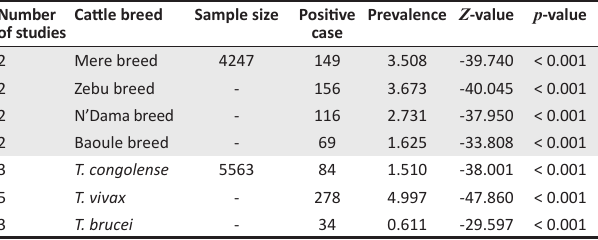
TABLE 3-A1: Pooled prevalence of bovine trypanosomiasis, stratified by bovine breed and trypanosome species. Number Cattle of studies